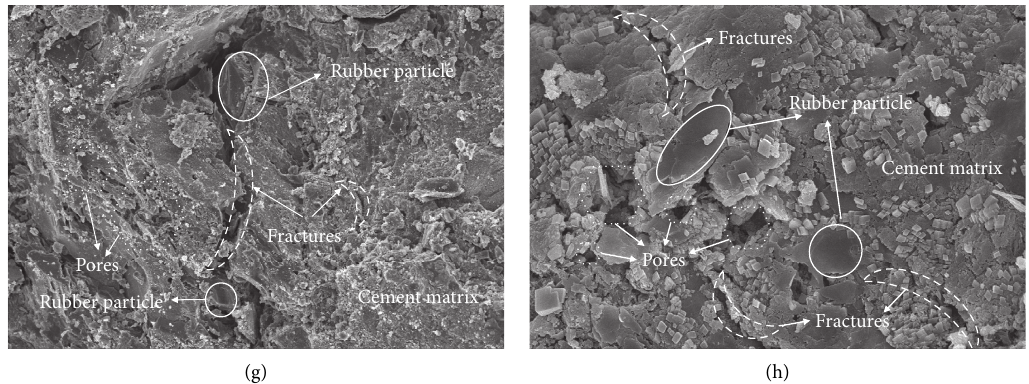
Figure 13: Microstructures of the interfacial transition zone, subjected to (a) 0 wet-dry cycles, (b) 0 wet-dry cycles, (c) 14 wet-dry cycles at 20 ° C, (d) 14 wet-dry cycles at 60 ° C, (e) 21 wet-dry cycles at 20 ° C, (f) 21 wet-dry cycles at 60 ° C, (g) 28 wet-dry cycles at 20 ° C, and (h) 28 wet- dry cycles at 60 °